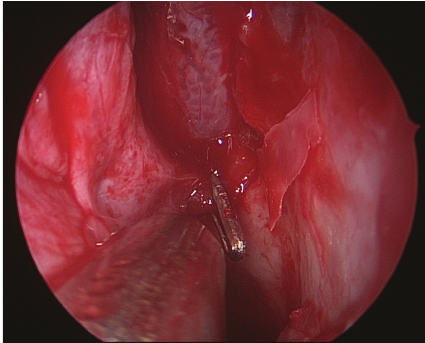
Figure 2: Endoscopic clipping of the left sphenopalatine